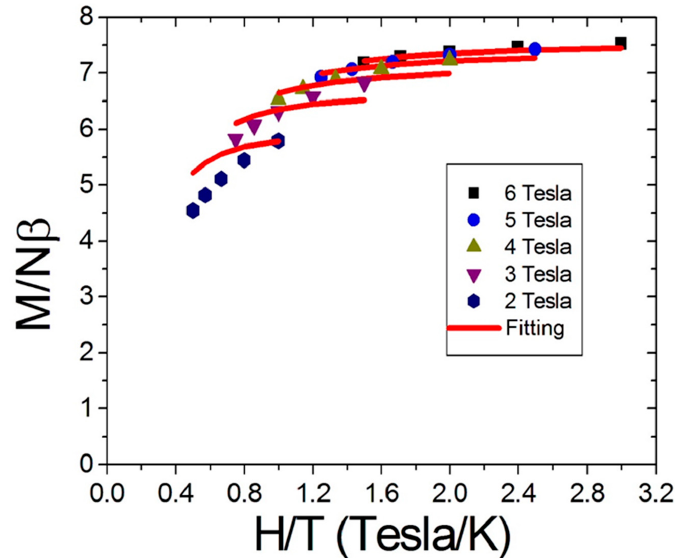
/ N β vs. H / T data indicated that the axial D term for compound 2 was Figure 6. The M/N β vs. H/T data indicated that the axial D term for compound 2 was significant. Figure 6. The M